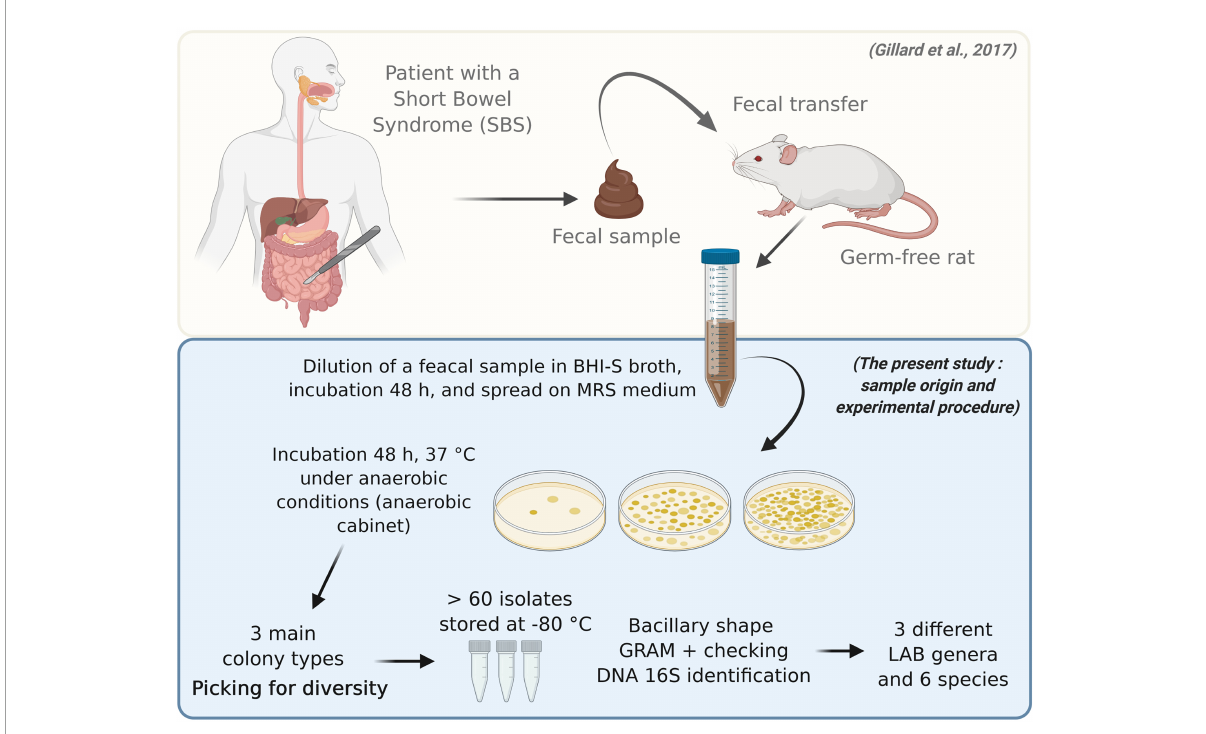
FIGURE2 Isolation, characterization, and identification of bacterial strains in the gut microbiota of a patient with short bowel syndrome. Feces from a germ-free rat that had previously been inoculated with fecal microbiota from an SBS patient were collected daily for 3 days and then twice a week for 30 days (37). The fecal sample displayed a stable microbial composition, similar to that of the inoculum. The sample was then incubated in rich, non-selective medium for 48 h, and serial dilutions were plated on MRS medium. The bacteria were incubated for 48 h at 37 ◦ C under anaerobic conditions. Various colony types were observed. More than 60 isolates were identified. They represented three genera and five species of lactic acid bacteria: L. rhamnosus , L. casei , L. camelliae , L. reuteri , and L. salivarius